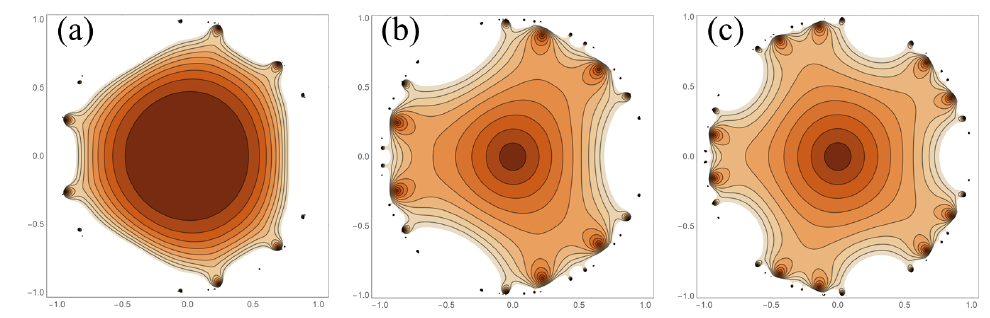
Figure 3. The example of lacunary functions generated from the Fibonacci sequence. Panel ( a ) shows the case for s = 3, N = 20, and h ( n ) = fib ( n ) . Panel ( b ) shows the case for s = 3, N = 20, and h ( n ) = fib ( n + 1 ) − 1. Panel ( c ) shows the same case as the middle panel but now s =